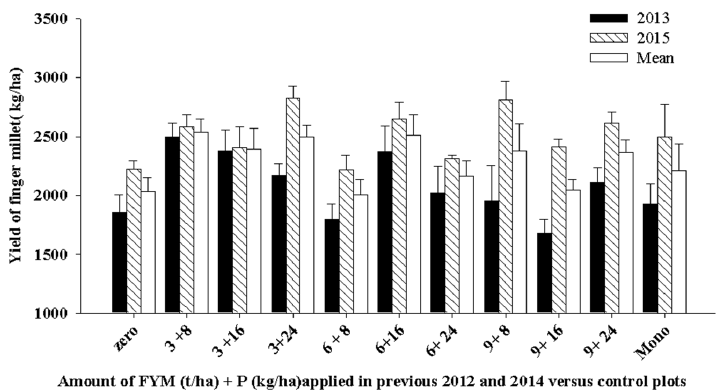
Figure 6. Residual effect of FYM combined with chemical P fertilizer applied to soybean precursor on the yield of subsequent finger millet at Bako, Western Ethiopia. Mono F.M = farmers’ practice, continuous mono ‐ cropping of finger millet with recommended use of DAP fertilizer.